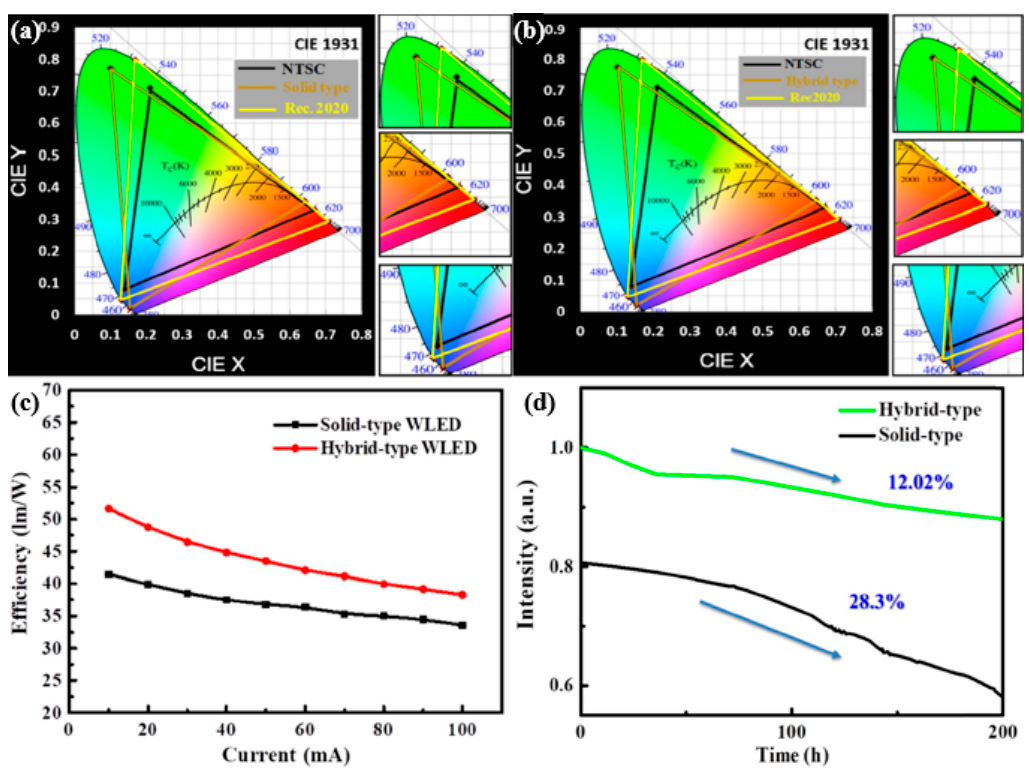
Color gamut on CIE 1931 color space for ( a ) solid and ( b ) hybrid-type WLED. ( c ) Luminance efficiency with respect to current. ( d ) Stability of solid- and hybrid-type WLEDs [74]. Figure reproduced with permission from Optical Society of America.